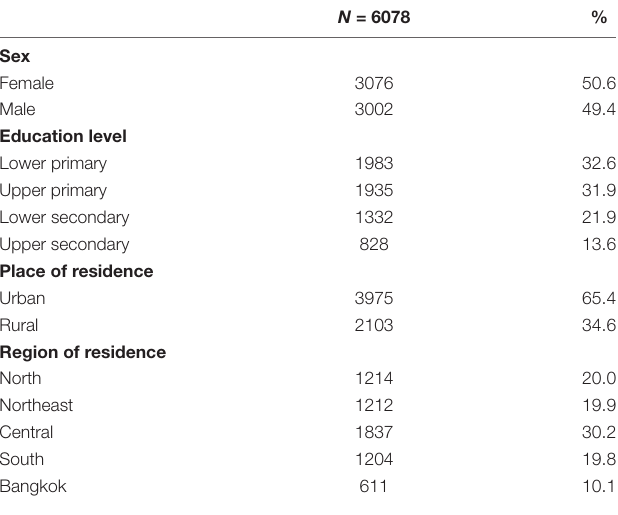
TABLE 1 | Participant